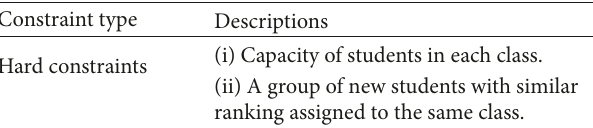
Table 13: The hard constraints within the NSAP adopted from Zukhri and Omar [105] and Hassim et al. [106].